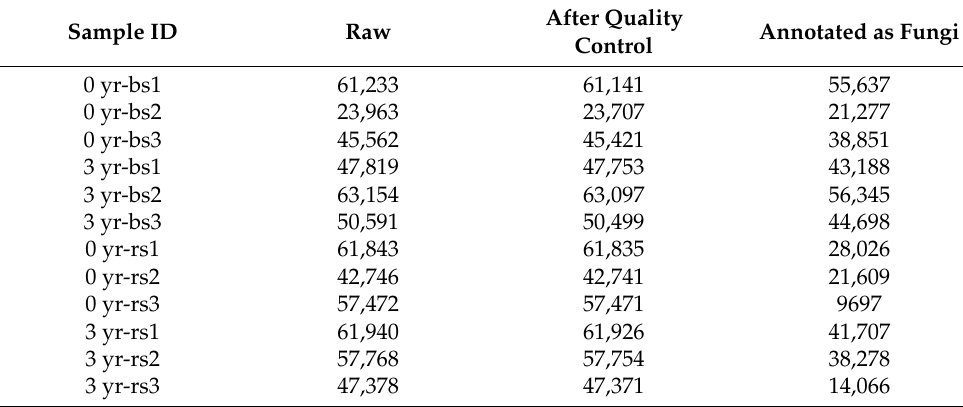
Table A2. The number of reads filtered from the ITS